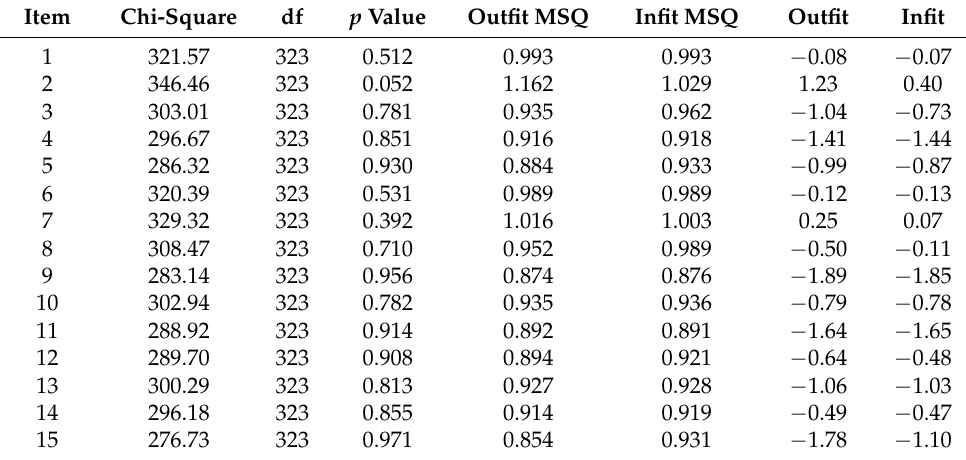
Table 4. Fit adjustment of the